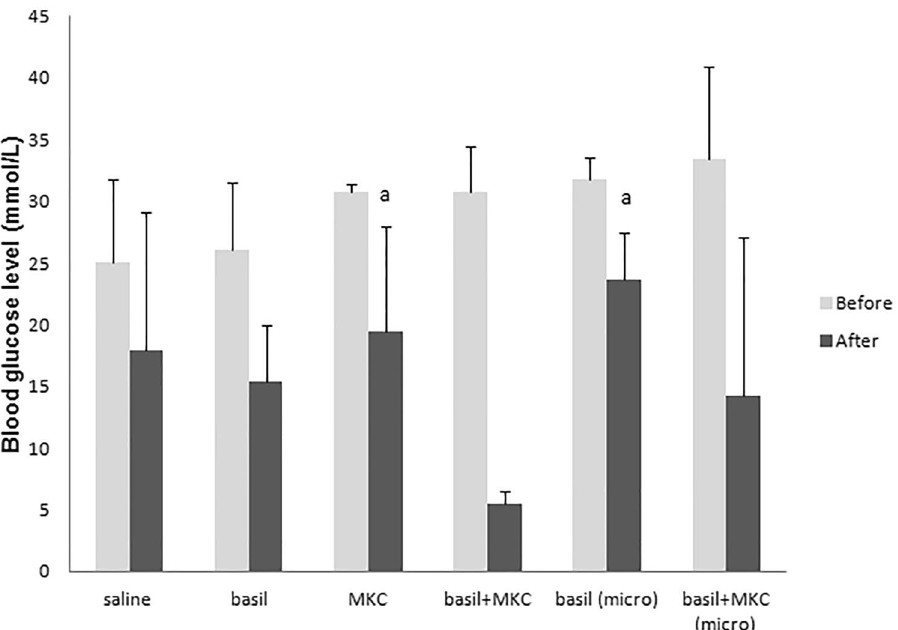
Figure 2. Blood glucose levels in diabetic animals before and after seven days of treatment; a p < 0.05 in relation to the group treated with basil and